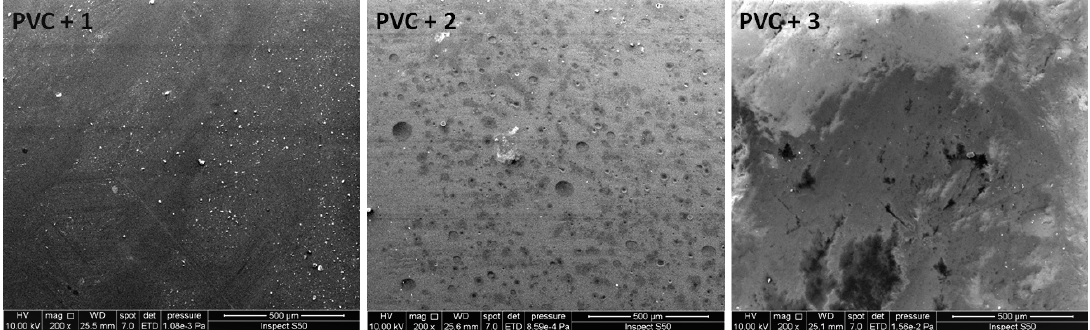
Figure 14. SEM images of PVC films containing polyphosphates 1 – 3 after irradiation.